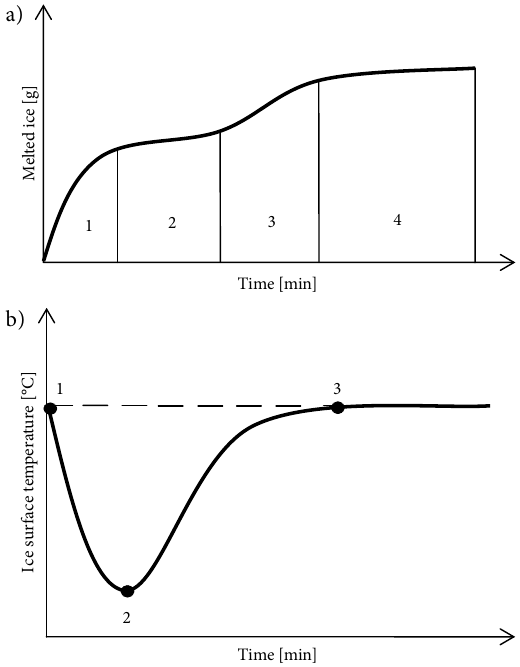
Fig. 1. Factors affecting ice melting and removing from the road